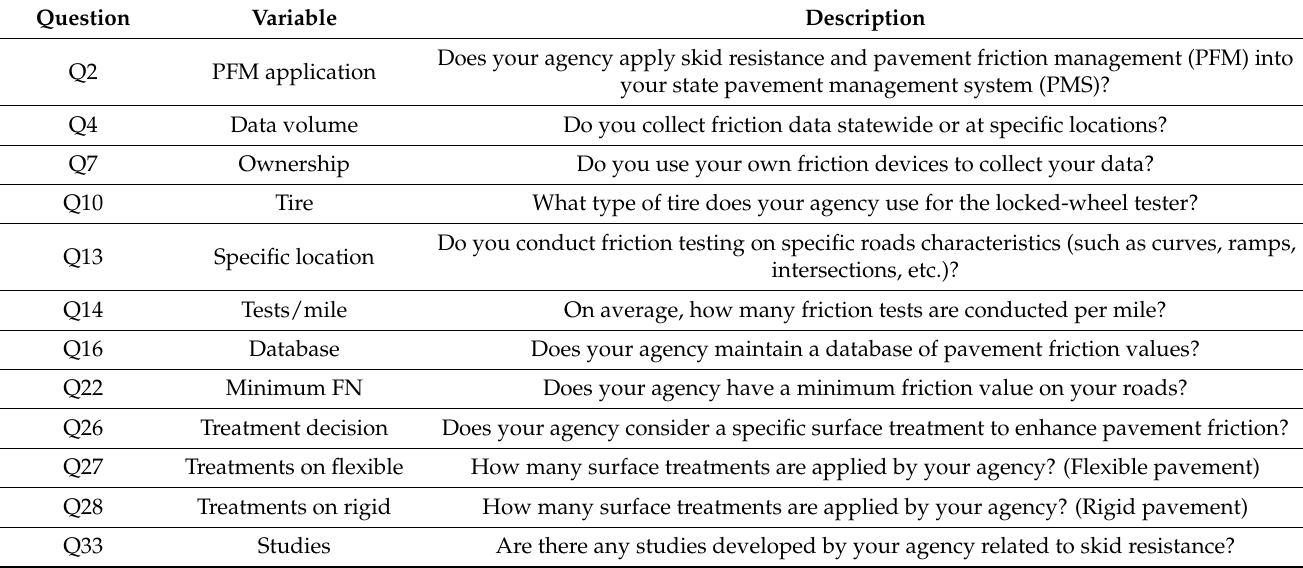
Table 1. Questions used in the correlation analysis and statistical